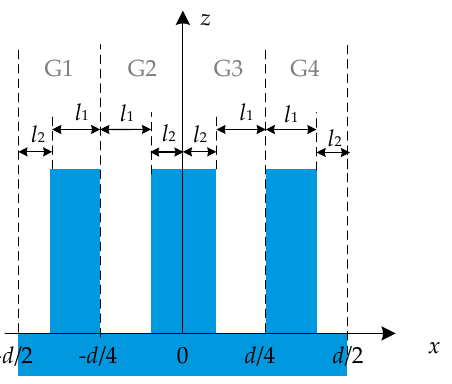
Figure 9. Segmented grating structure with even orders eliminated. When the number of ridges N = 3 and the groove depth h = λ /4, the grating structure is shown in Figure 10, and its structural parameters satisfy the following